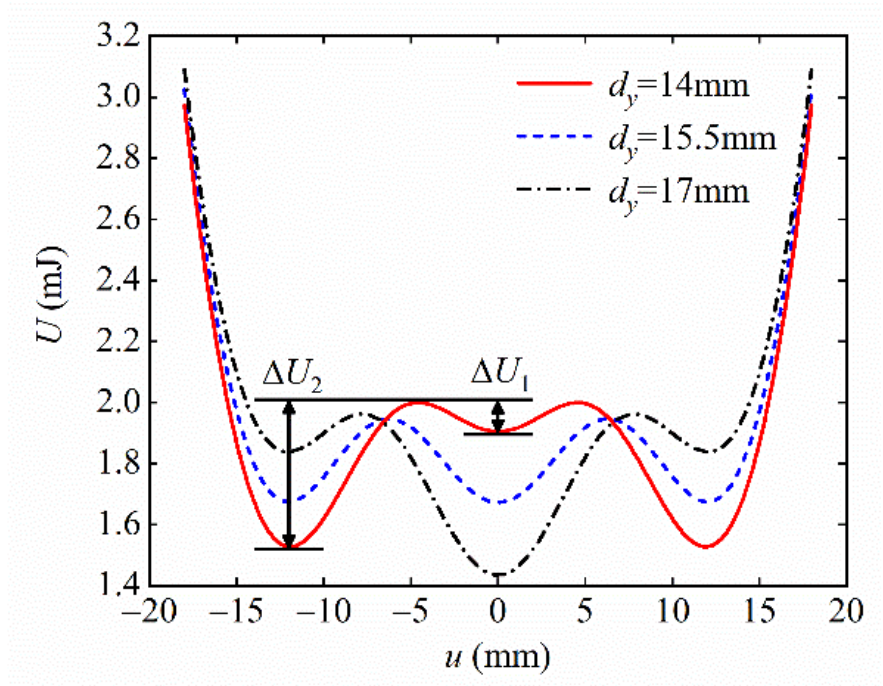
Figure 8. Potential energy curve of the system.